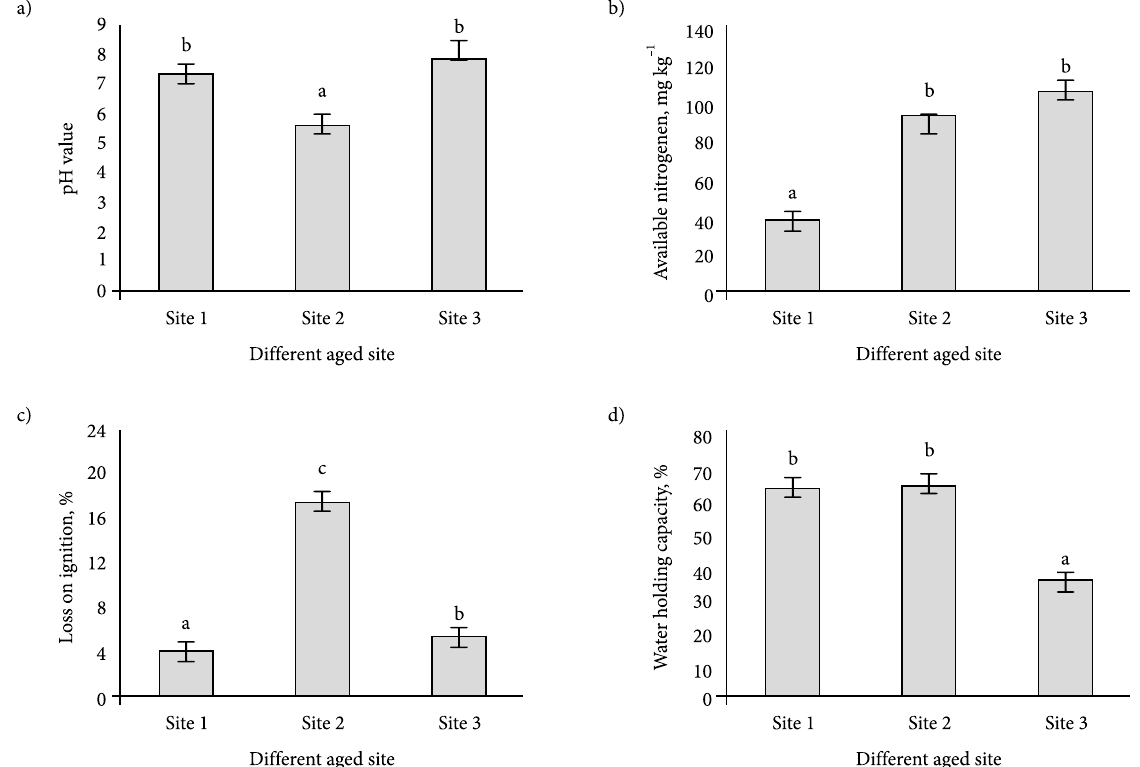
Fig. 2. Physicochemical parameters of rhizospheric samples from different aged fly ash dump sites such as pH (a); available nitrogen (b); loss on ignition (c); water holding capacity (d) for n = 7 replicates. The deviation between the data for each individual parameter for a site has been shown as error bars. Different alphabetical letters above each bar for a graph depict significant differences between the means at p <